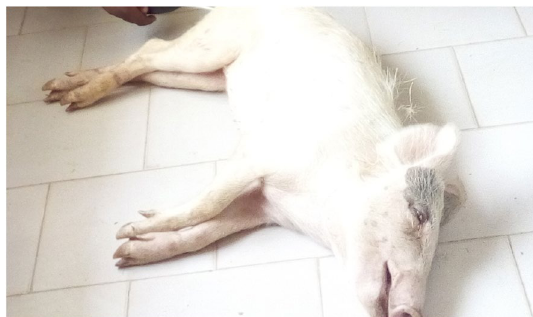
Fig. 3 Sus scrofa domesticus immediately after sacrifice (day 1 — fresh stage)